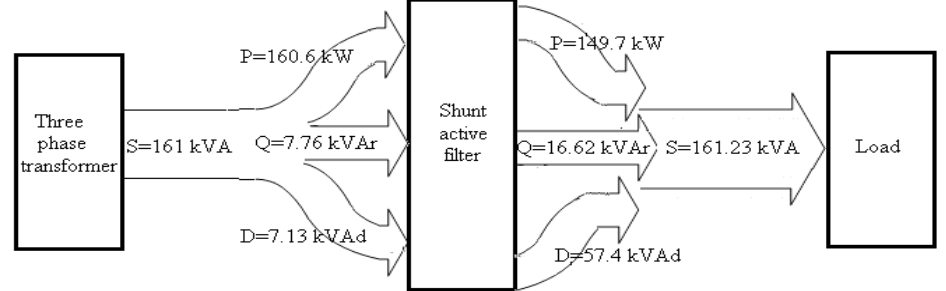
Figure 14. Diagram of power flows when a PAF is connected.